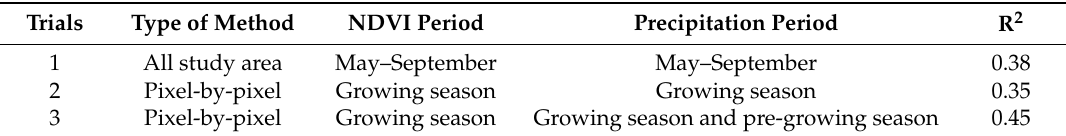
Table 1. VPR of the three trials at the overall level.